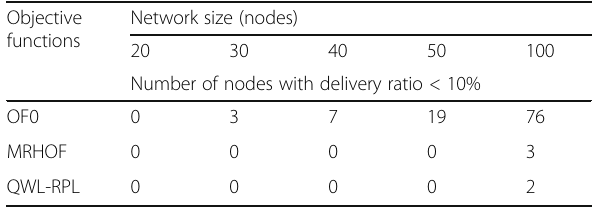
Table 5 Illustrating scenario II network imbalance with delivery ratio